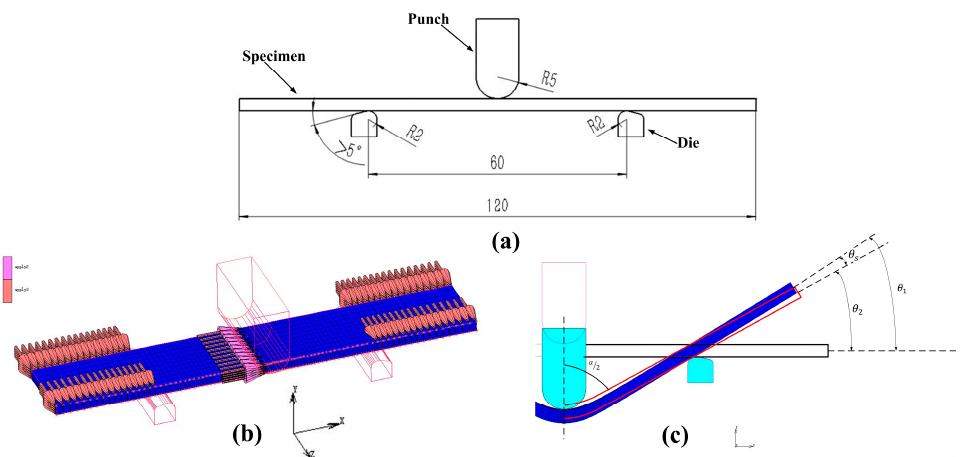
Figure 5. Finite element model of the three-point bending. ( a ) Parameters of three-point bending test; ( b ) Finite element model; ( c ) Evaluation index of springback